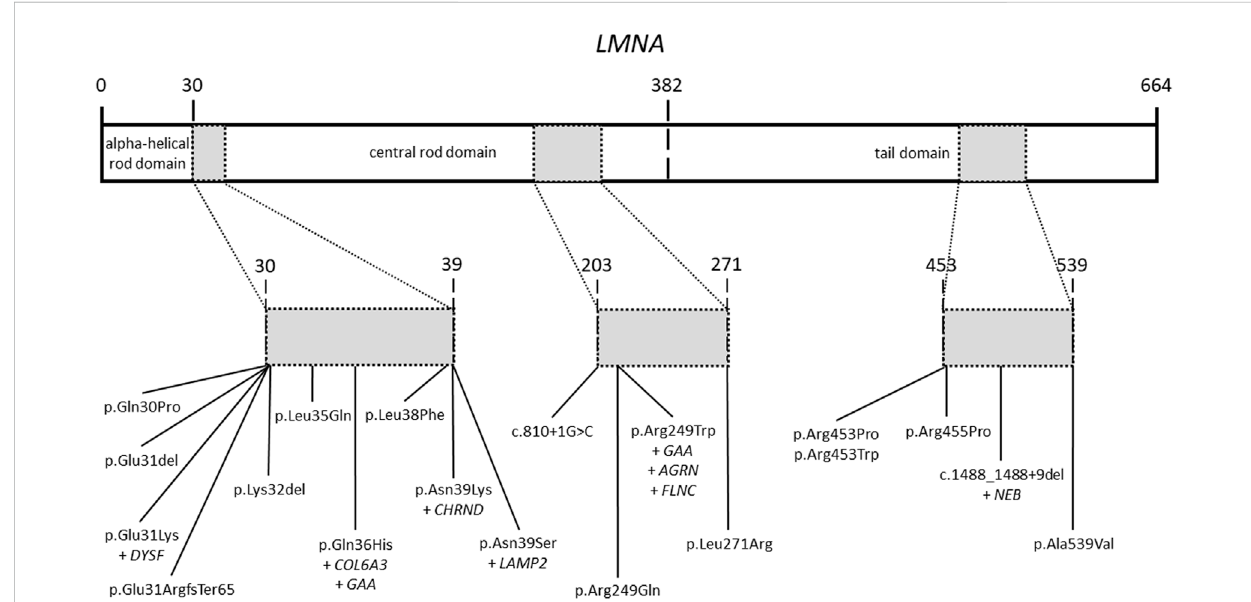
FIGURE 2 Rarevariantsinthe LMNA gene.Domainsofthe LMNA geneincludingrarevariantsidenti fi edinourpatients.Allrarevariantsarelocatedinthreemain zones of the